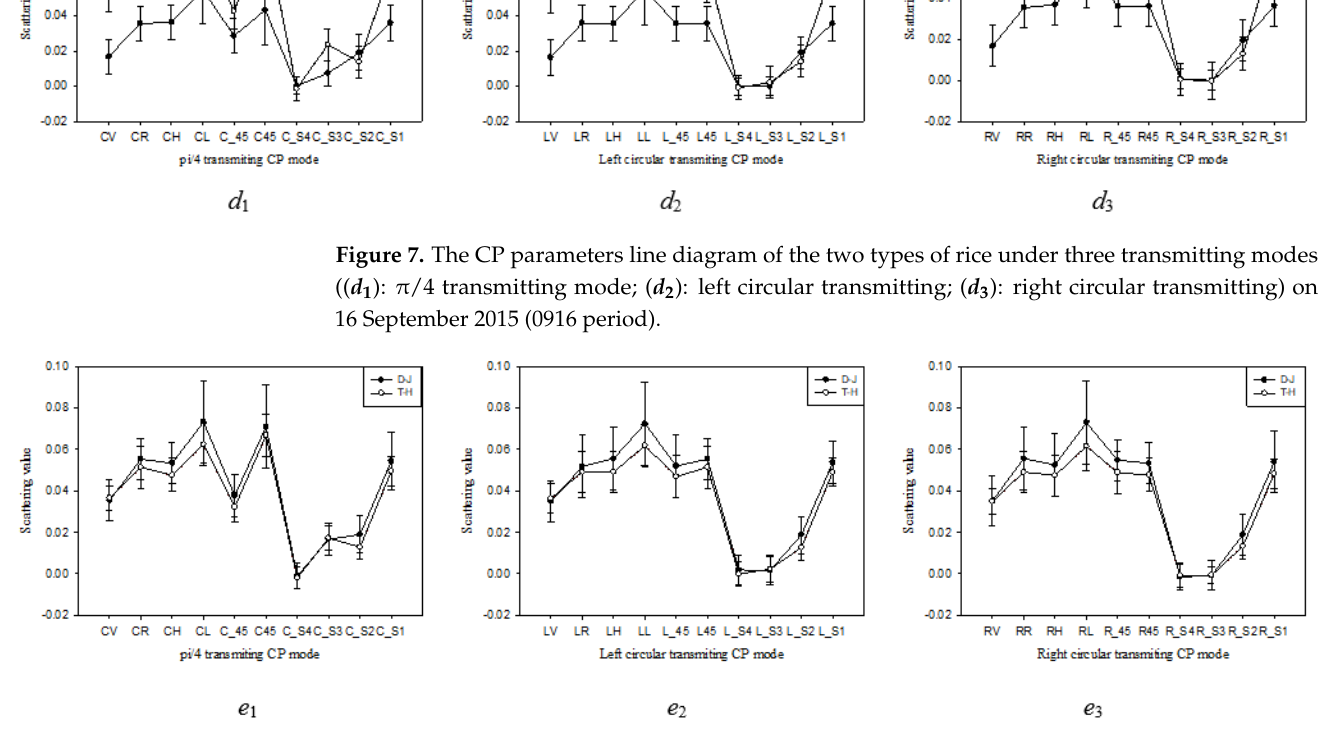
Figure 8. The CP parameters line diagram of the two types of rice under three transmitting modes